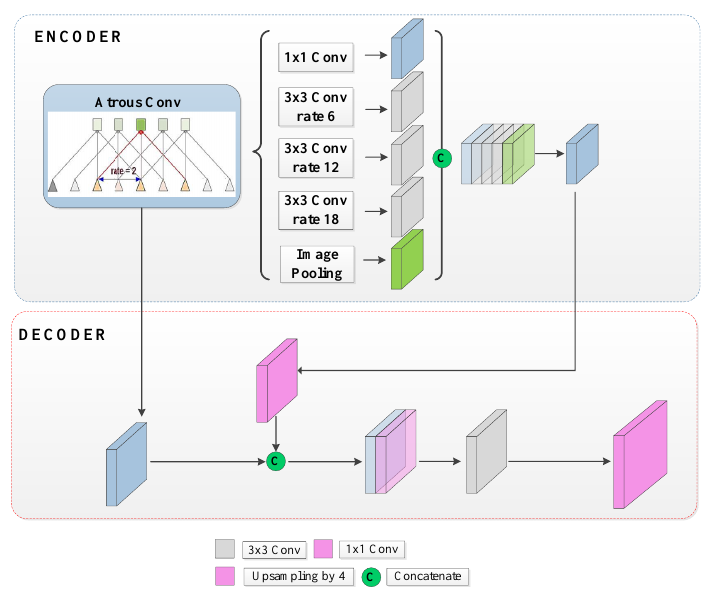
Figure 6. DeepLabv3+